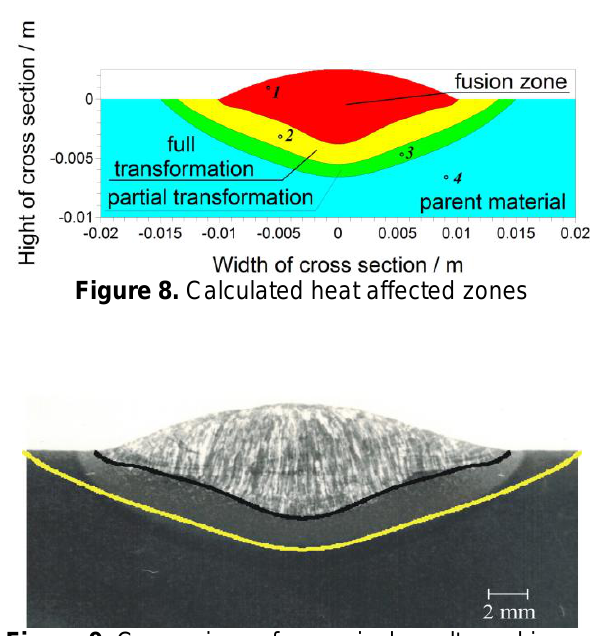
Figure 9. Comparison of numerical results and image of metallographic section